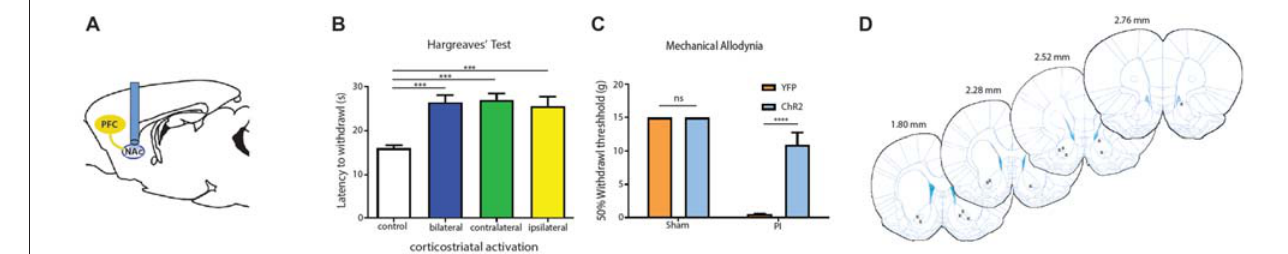
FIGURE 6 | PFC neurons project to the NAc core to relieve acute pain. (A) Schematic showing fiber placement and optogenetic activation of NAc core neurons. ChR2 was injected into the PL-PFC. Four weeks later, we activated the PFC-NAc projection using fibers implanted in the NAc core. (B) Bilateral ( n = 7, p < 0.0007), contralateral ( n = 7, p < 0.001) and ipsilateral ( n = 7, p = 0.0009) activation of prefrontal neurons that project to the NAc core caused an increase in the latency to paw withdrawal during Hargreaves’ test when compared to control ( n = 7). Two-tailed paired Student’s t test. (C) Light activation of the PFC-NAc circuit decreased mechanical allodynia in PI-, but not sham-treated rats. Light treatment did not have any effect on animals which received vectors containing YFP-only n = 4–10, p < 0.0001. Two-way ANOVA with Bonferroni post-test. Light activation was performed 4 weeks after PI/sham procedures. Error bars show mean and SEM. (D) Diagram showing the locations of optic fibers in the NAc core. ∗∗∗ p < 0.001, ∗∗∗∗ p < 0.0001.